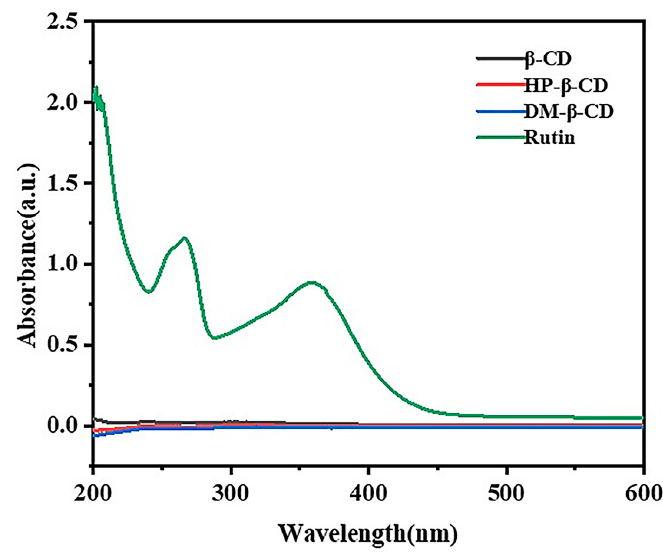
Figure 5. UV spectra of β -CD, HP- β -CD, DM- β -CD and rutin.